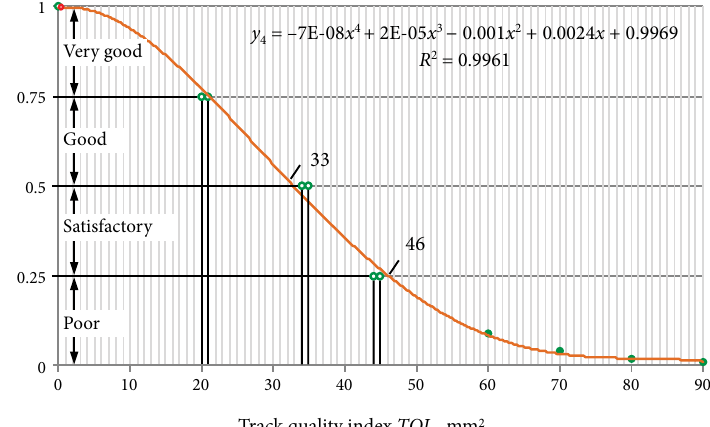
Fig. 6. The regression equation and the curve used for determining 1 A x ′ value for the first criterion of group A, when the real TQIfs is